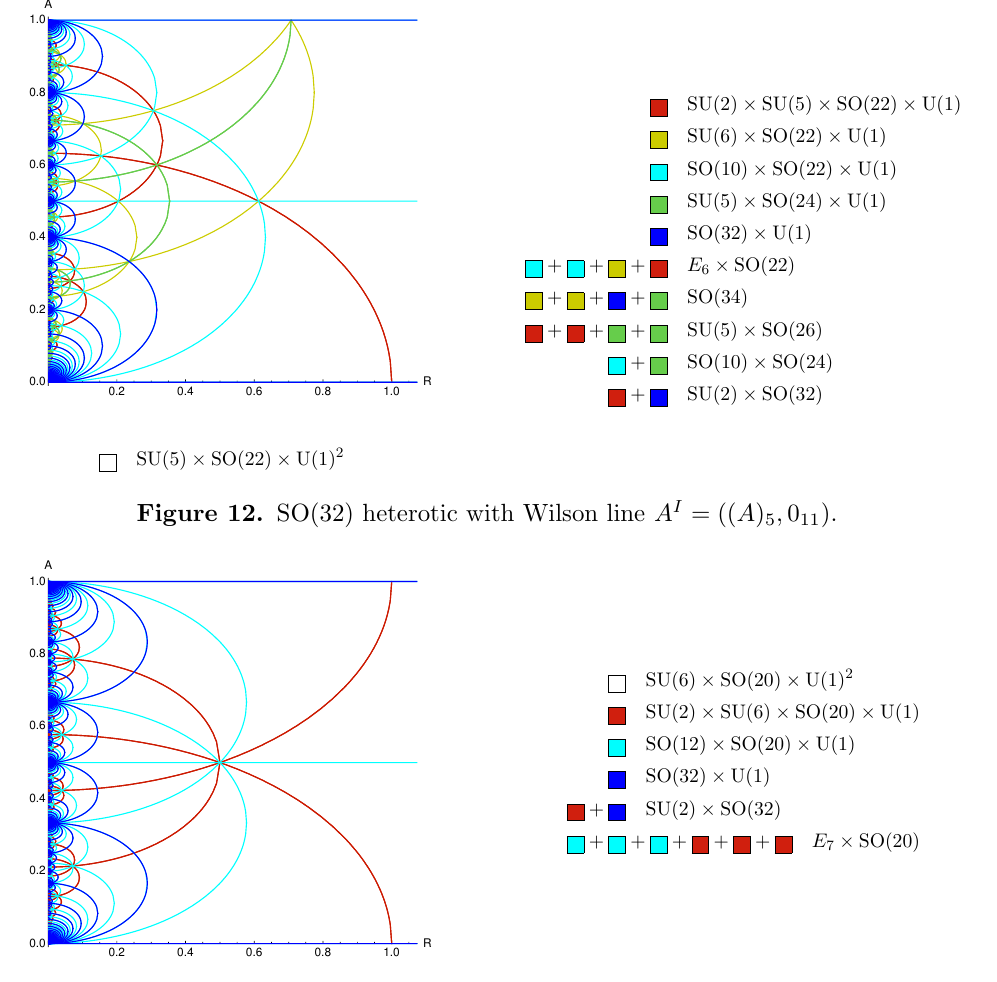
Figure 13. SO(32) heterotic with Wilson line A I = (( A ) 6 ; 0 10 ).